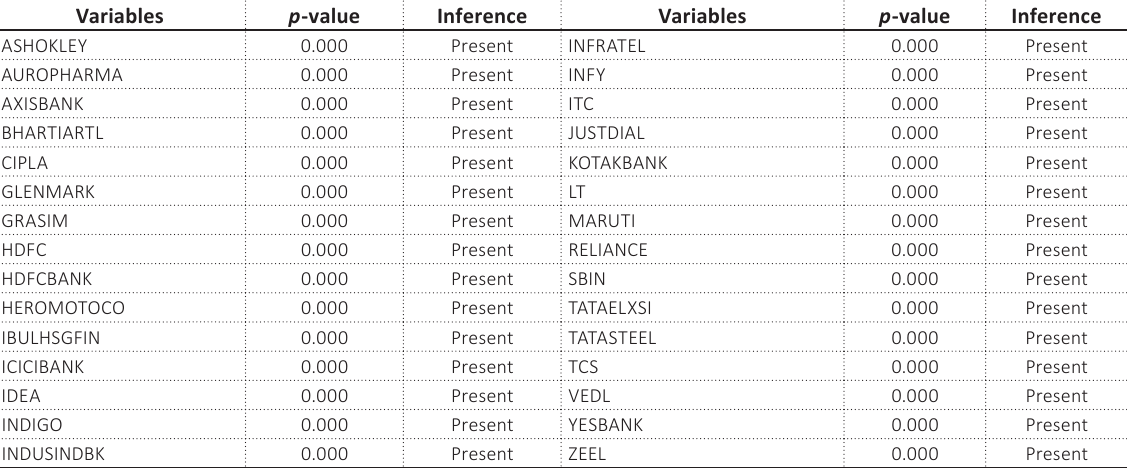
Table 3. Results of ARCH test